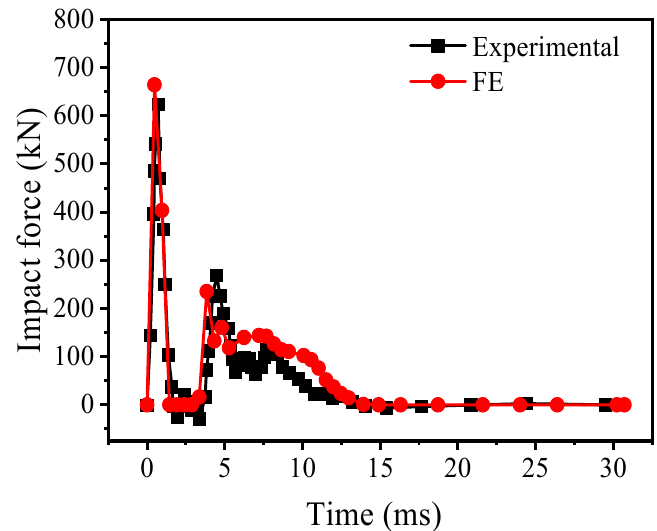
Figure 4. Comparison of impact force time histories obtained from the FE simulation and experimental test.